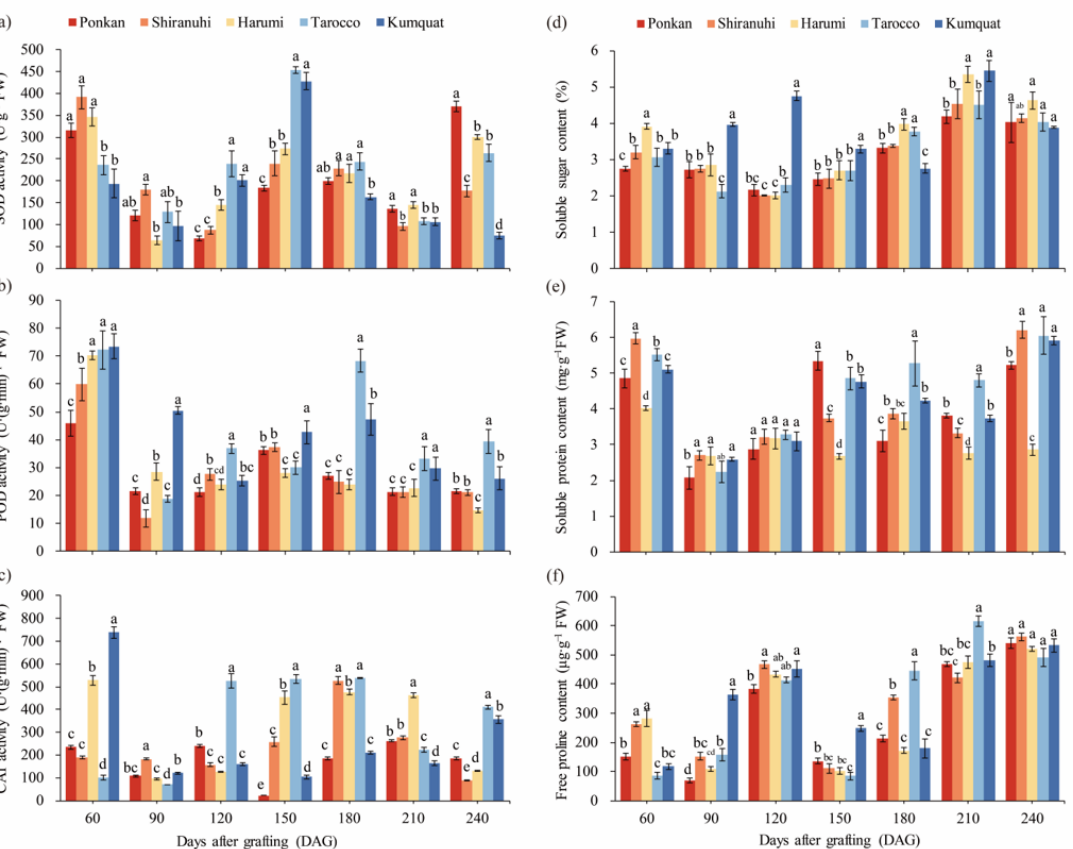
Figure 2. Effects of different interstocks on antioxidant enzyme activities and osmotic adjustment substances of ‘Yuanxiaochun’ citrus leaves. ( a ) SOD, ( b ) POD, ( c ) CAT, ( d ) soluble sugar, ( e ) soluble protein, ( f ) free proline. The data were analyzed using Duncan’s multiple range test in SPSS software. The lowercase letters indicate statistically significant differences among treatments ( p < 0.05), and data are the mean ± SE of three replicates.